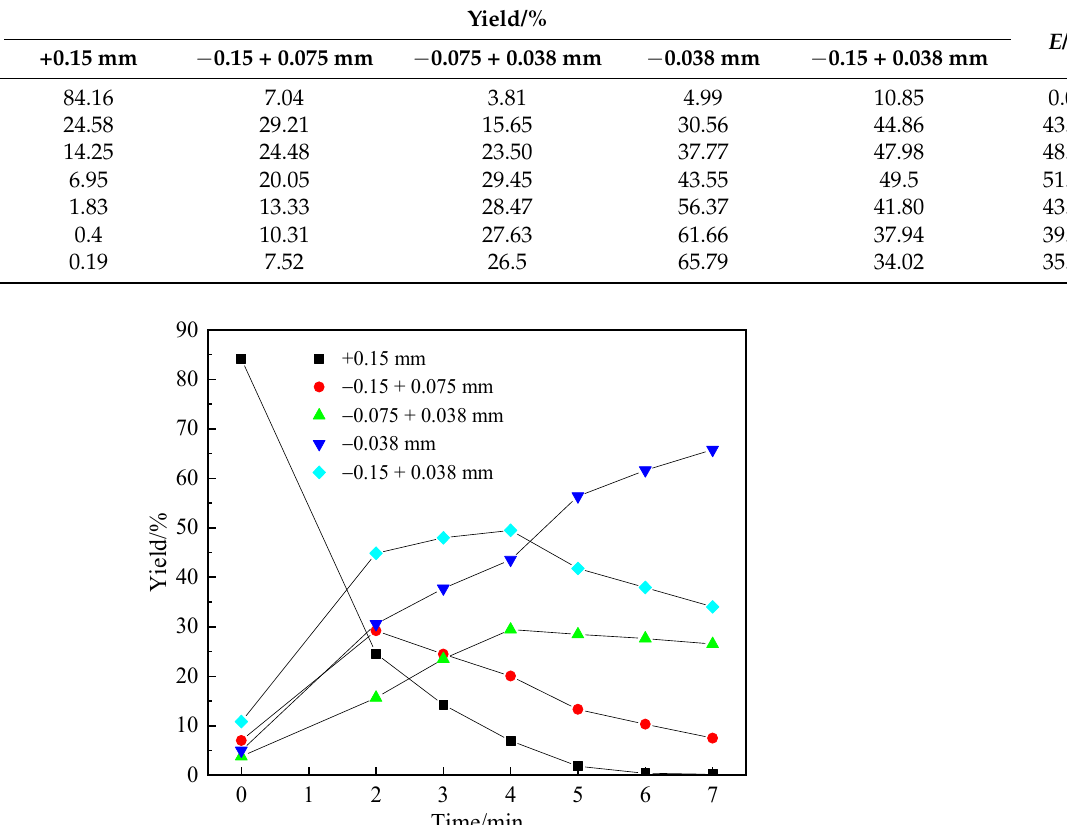
Table 8. Particle size composition of grinding product at different grinding times.